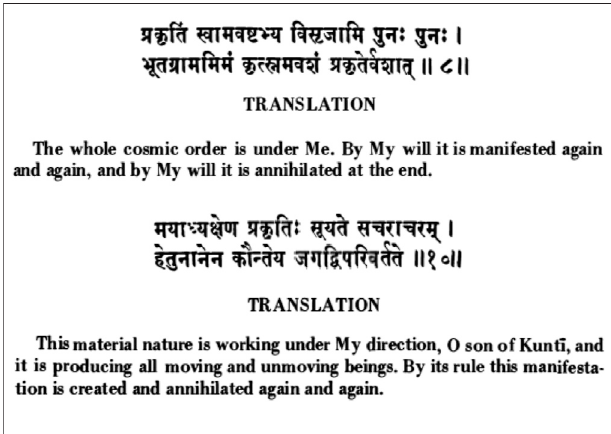
FIGURE2| Description ofNature and itsphenomenain Bhagwat Gita in Sanskrit and English (from Prabhupada and Swami, 1972).